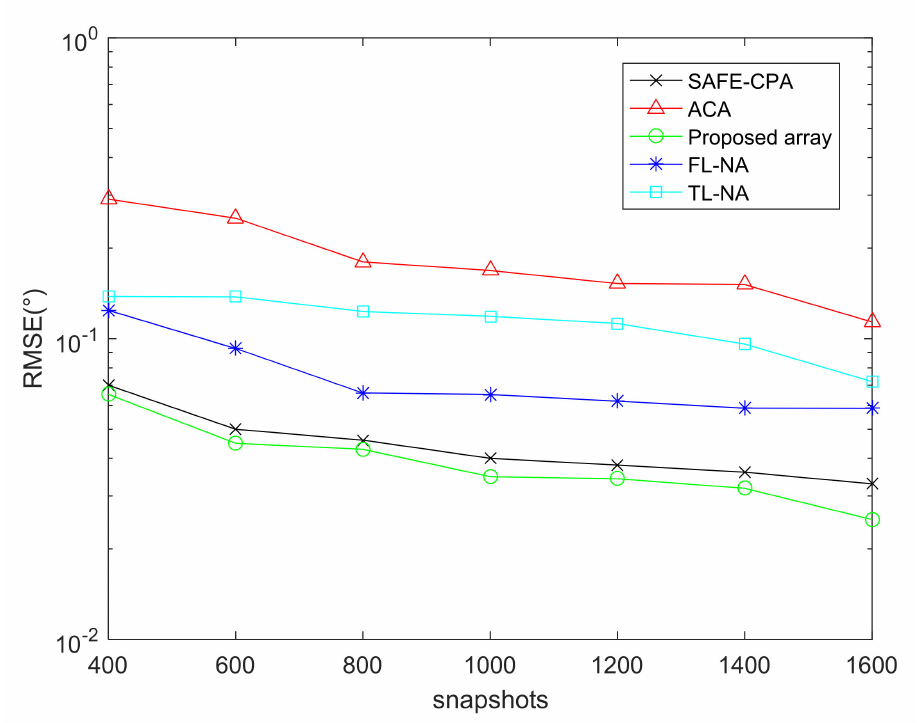
Figure 9. RMSE performance comparison versus